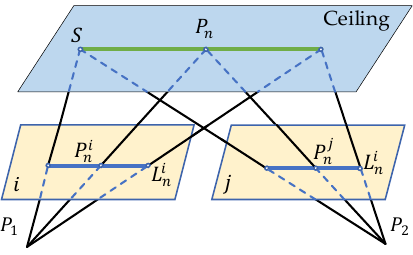
Figure 4. The projection of the spatial straight line S is marked as L i n and L j n on different imaging planes. The corresponding points on two 2D lines have the constraint of the homography matrix H ij : P j n H ij L i n = 0, where L i n is the plane line on the i -th frame and P j n is an any point on the straight line L j n on the j -th